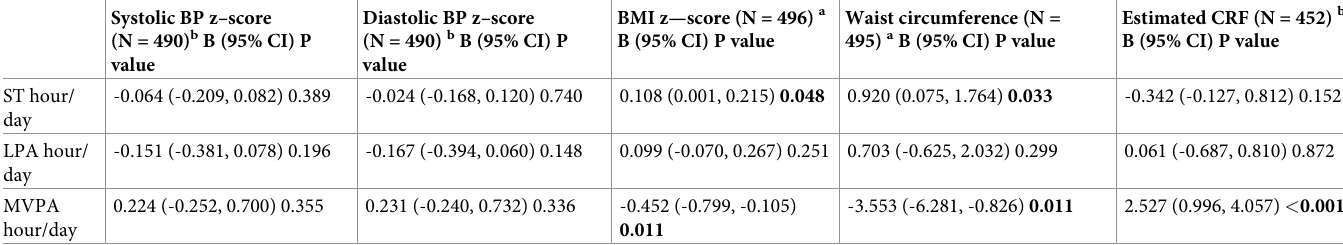
Table 4. Associations between PA intensities and cardiovascular risk